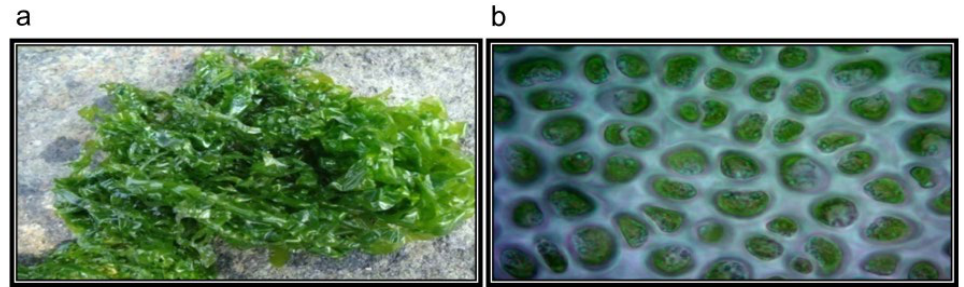
Figure 13. Macroscopic and cross-section image of U. reticulata. ( a ) Macroscopic view of U. reticulata , which appears like long thalli (mature) and color ranges from light to dark green. ( b ) Microscopic- axial view of U. reticulata (magnification 40×).